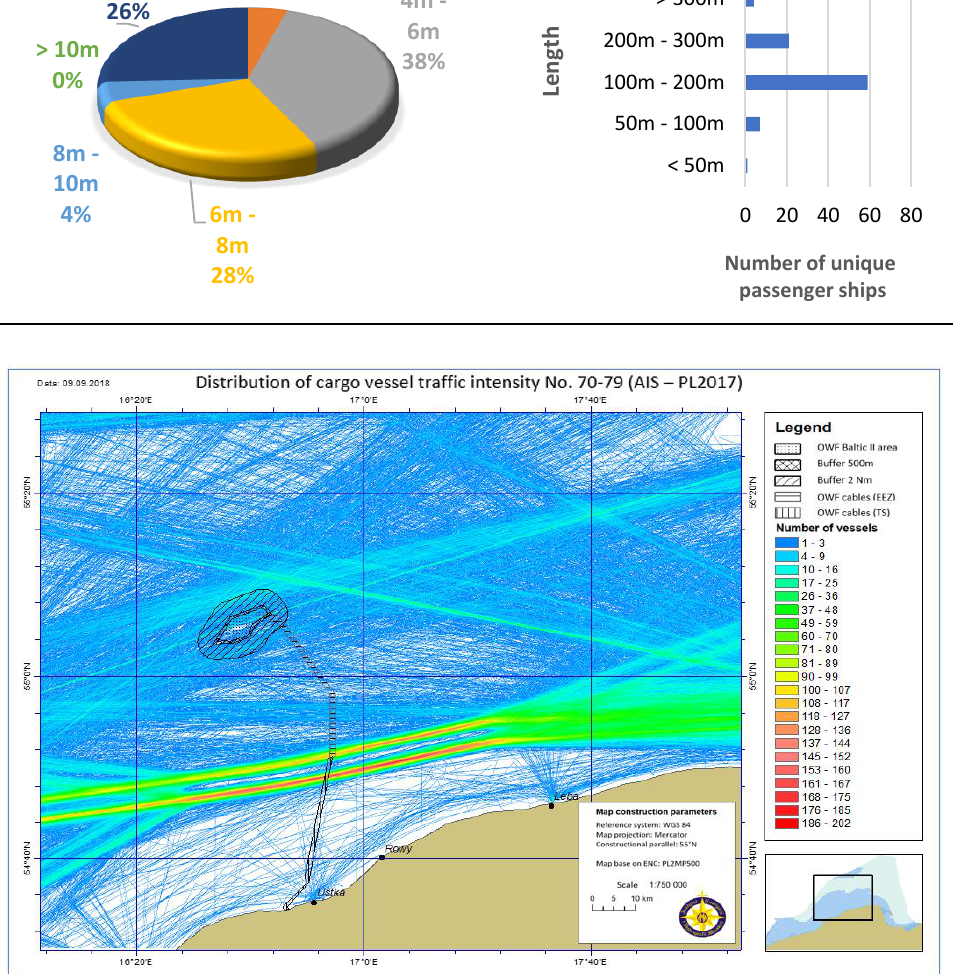
Figure 7. Distribution of cargo ship traffic intensity covering a large sea area around the OWF (ship type numbers: 70 – 79, AIS-PL 2017).